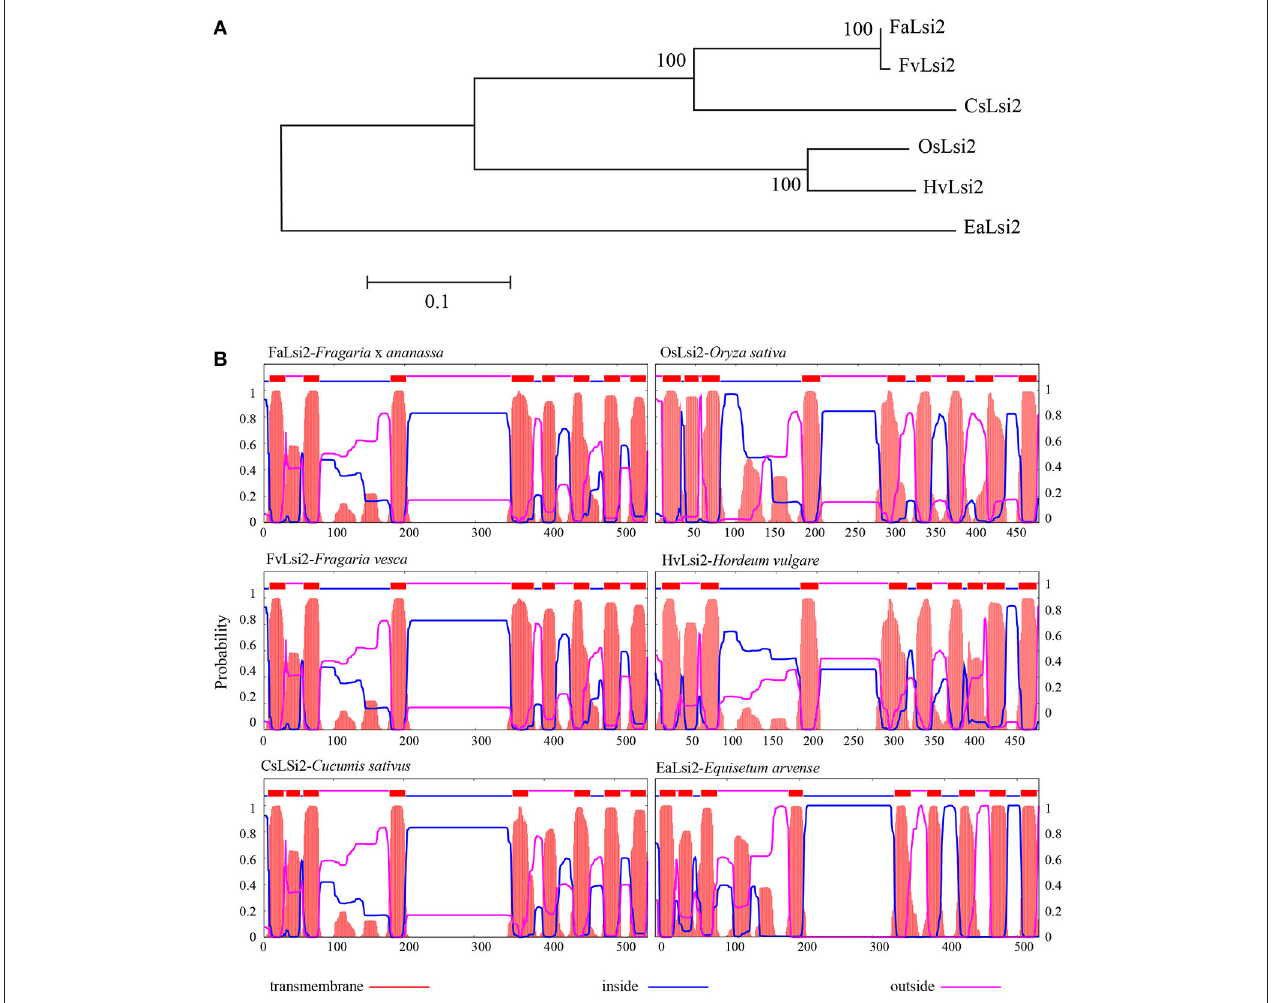
FIGURE 2 | (A) Phylogenetic relationship between the efflux silicon transporter (FaLsi2) identified in Fragaria × ananassa (Fa) and other plant species and (B) distribution of the 11 transmembrane domains predicted in Fragaria × ananassa protein with those of Fragaria vesca (Fv) and the four functional Si efflux transporters previously identified in four plant species, predicted with TMHMM tool (http://www.cbs.dtu.dk/). The entire protein sequences are provided in Supplementary Data sheet 1. Cs, Cucumis sativus , Hv, Hordeum vulgare , Os, Oryza sativa , Ea, Equisetum